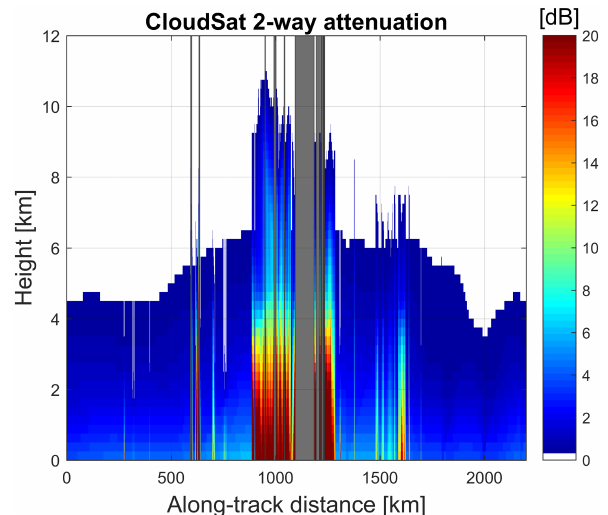
Figure 4. Two-way attenuation as retrieved in the 2C-RAIN product for the scene shown in Fig. 3. Grey bands correspond to profiles for which the retrieval in the 2C-RAIN product is not applicable. Data are provided at CloudSat resolution (1.1km horizontal, 0.5km